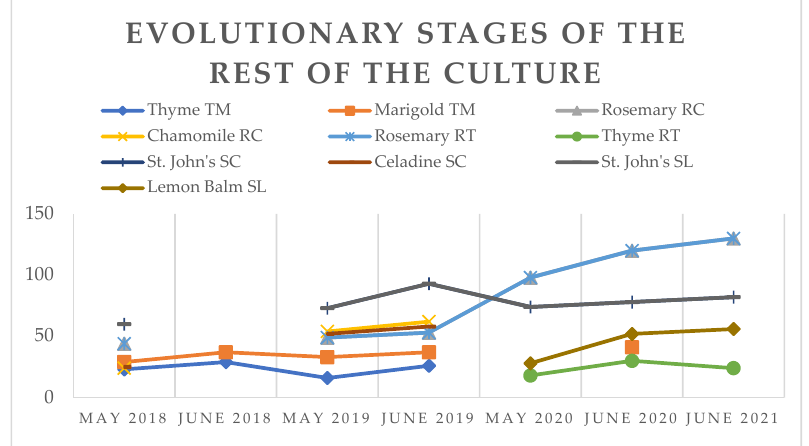
Figure 8. The evolution and dynamics of the whole culture during our study.